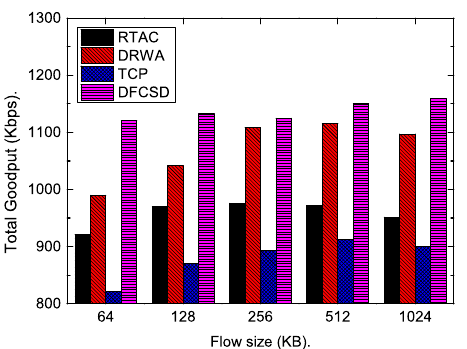
Figure 12. The obtained goodput of the network when the size of the competing short flow varies from 128 KB to 1024 KB.